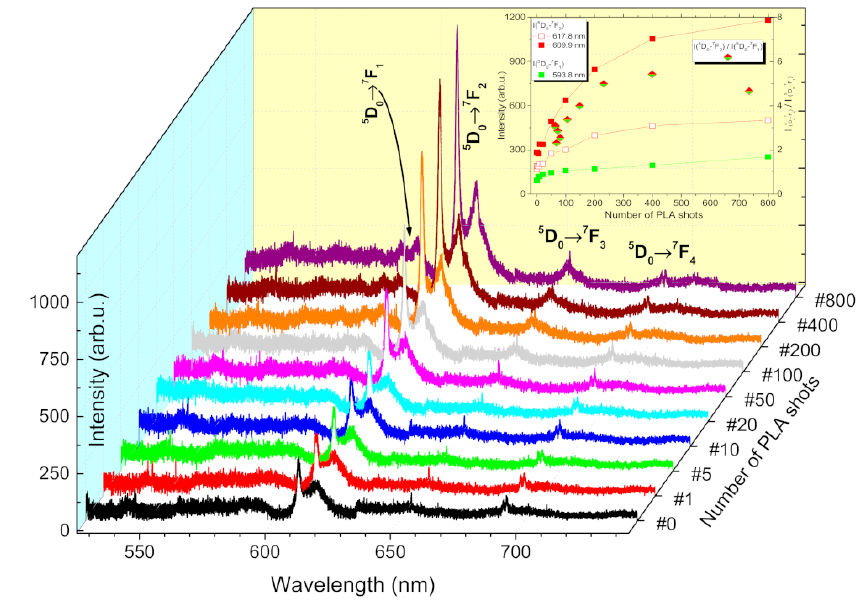
Figure 2. PL emission spectra of ZnO:Eu thin film, dependence on the number of PLA shots.